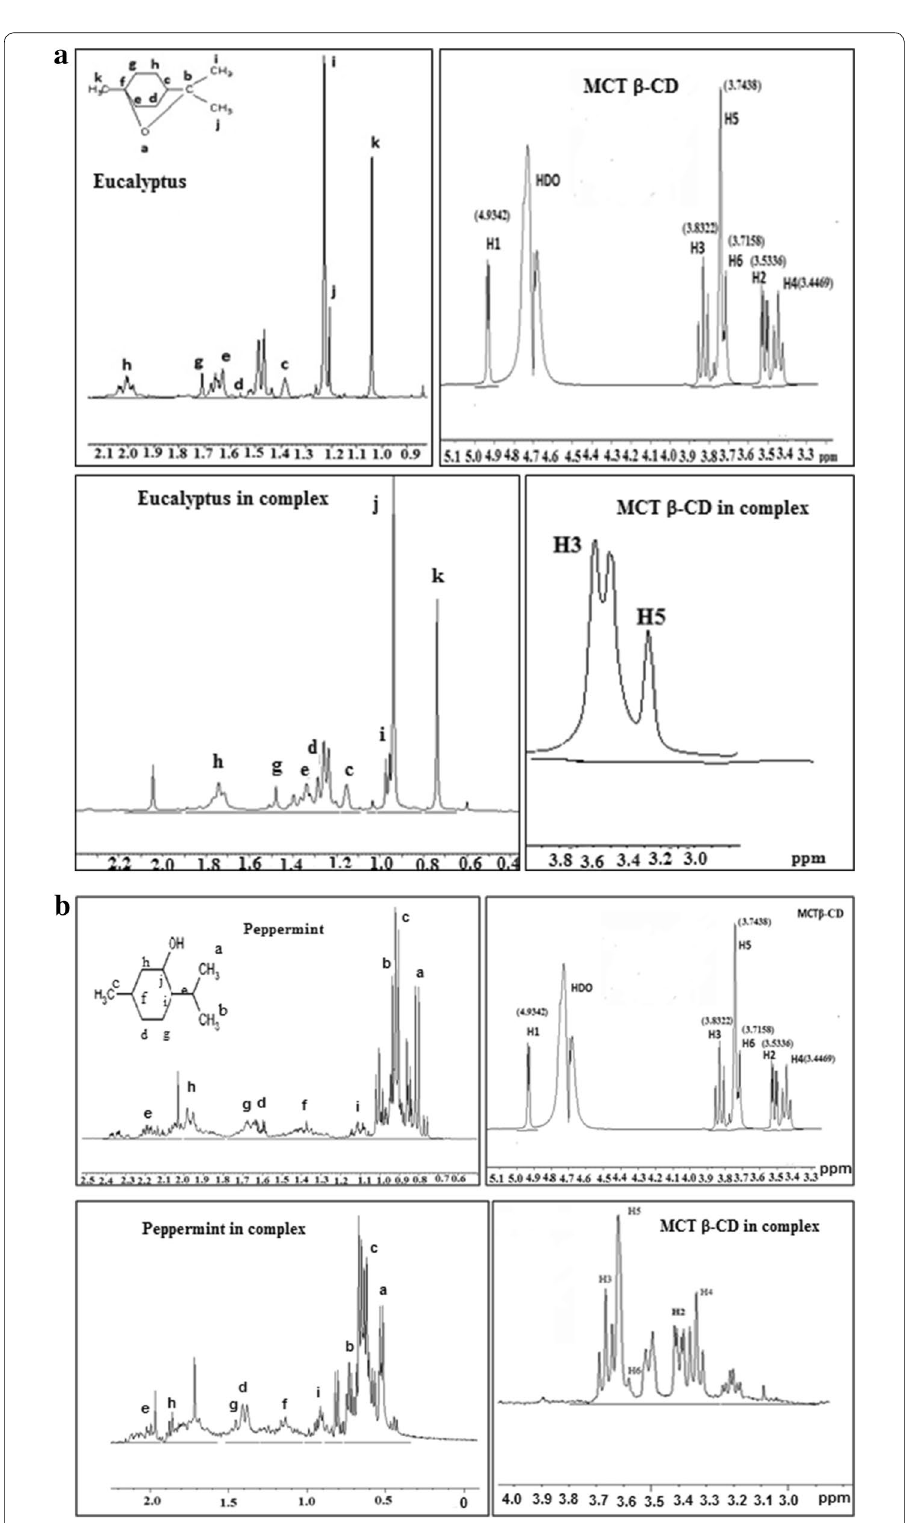
Fig. 8 1 H-NMR spectral analysis of MCT β-CD in free and complex state with essential oils in free and com- plex states. a Eucalyptus b